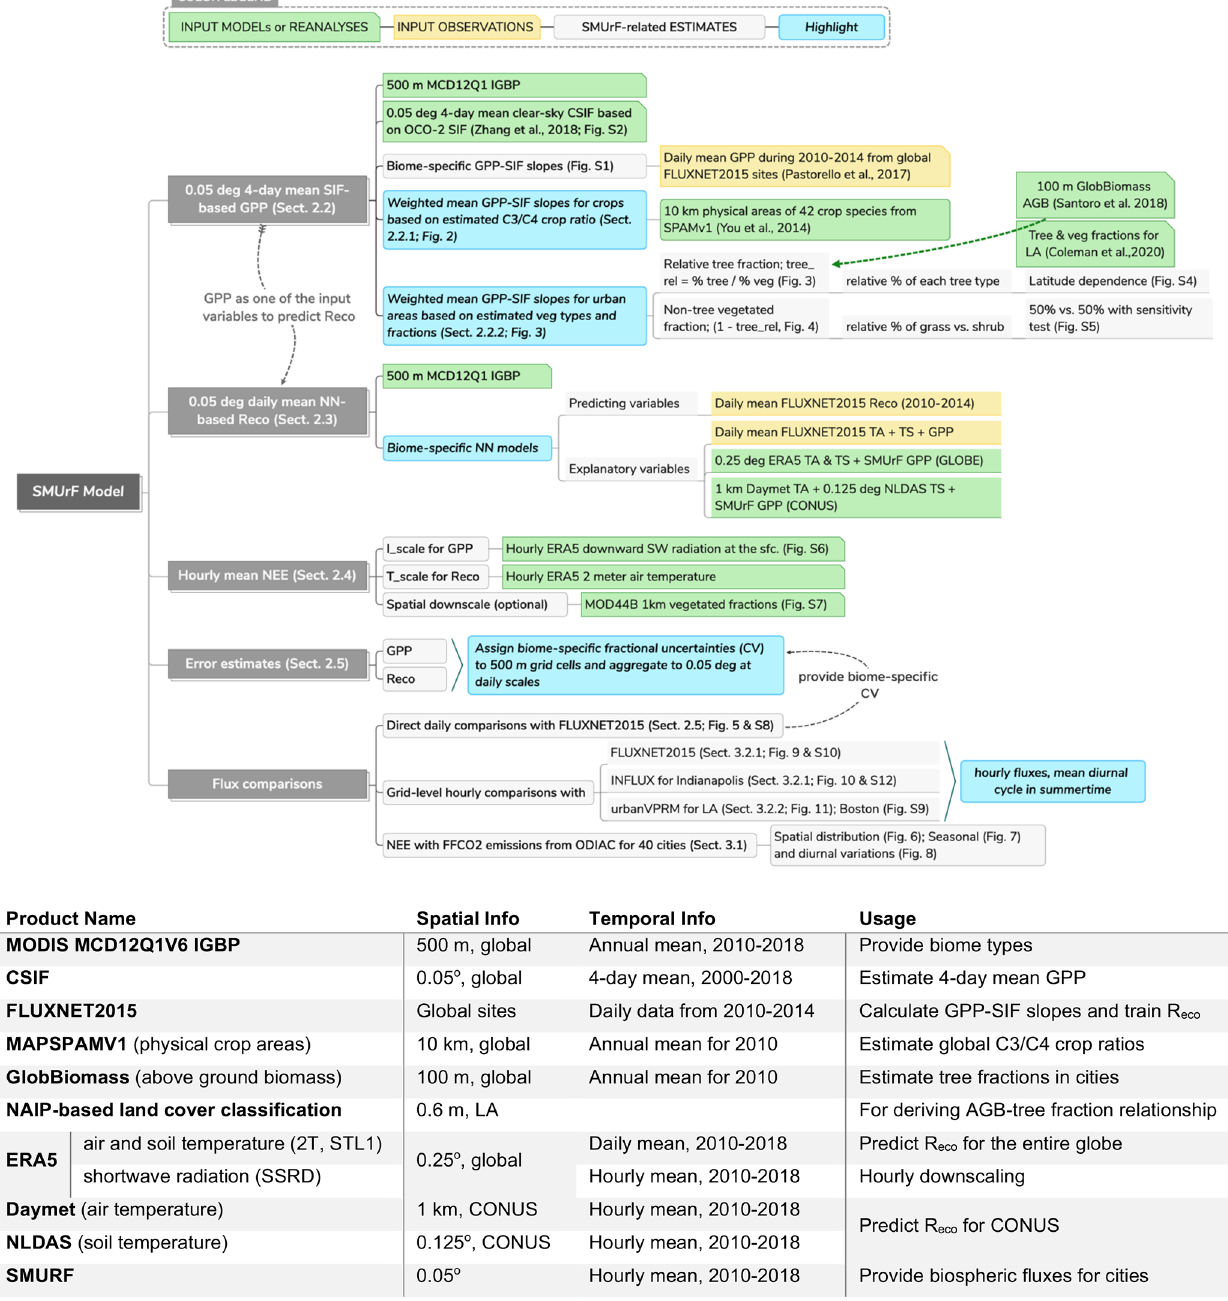
Figure 1. A demonstration of SMUrF (flowchart) and a description of input data products and observations (summarized in the table). The temporal coverage in the table indicates the years used in this